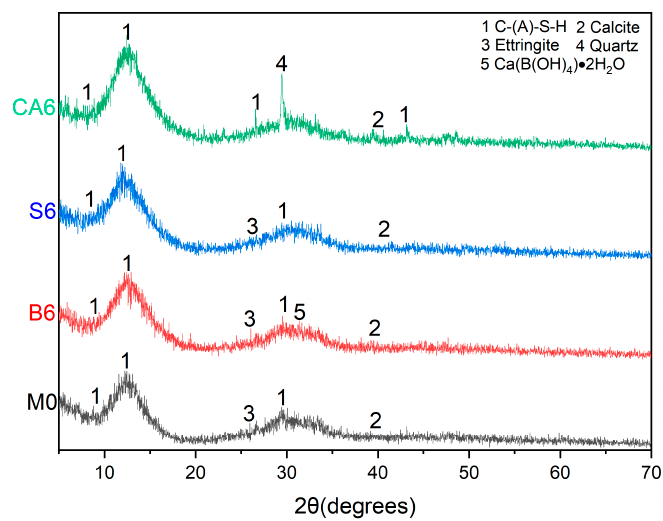
Figure 12. XRD patterns of M0, B6, S6, and CA6.